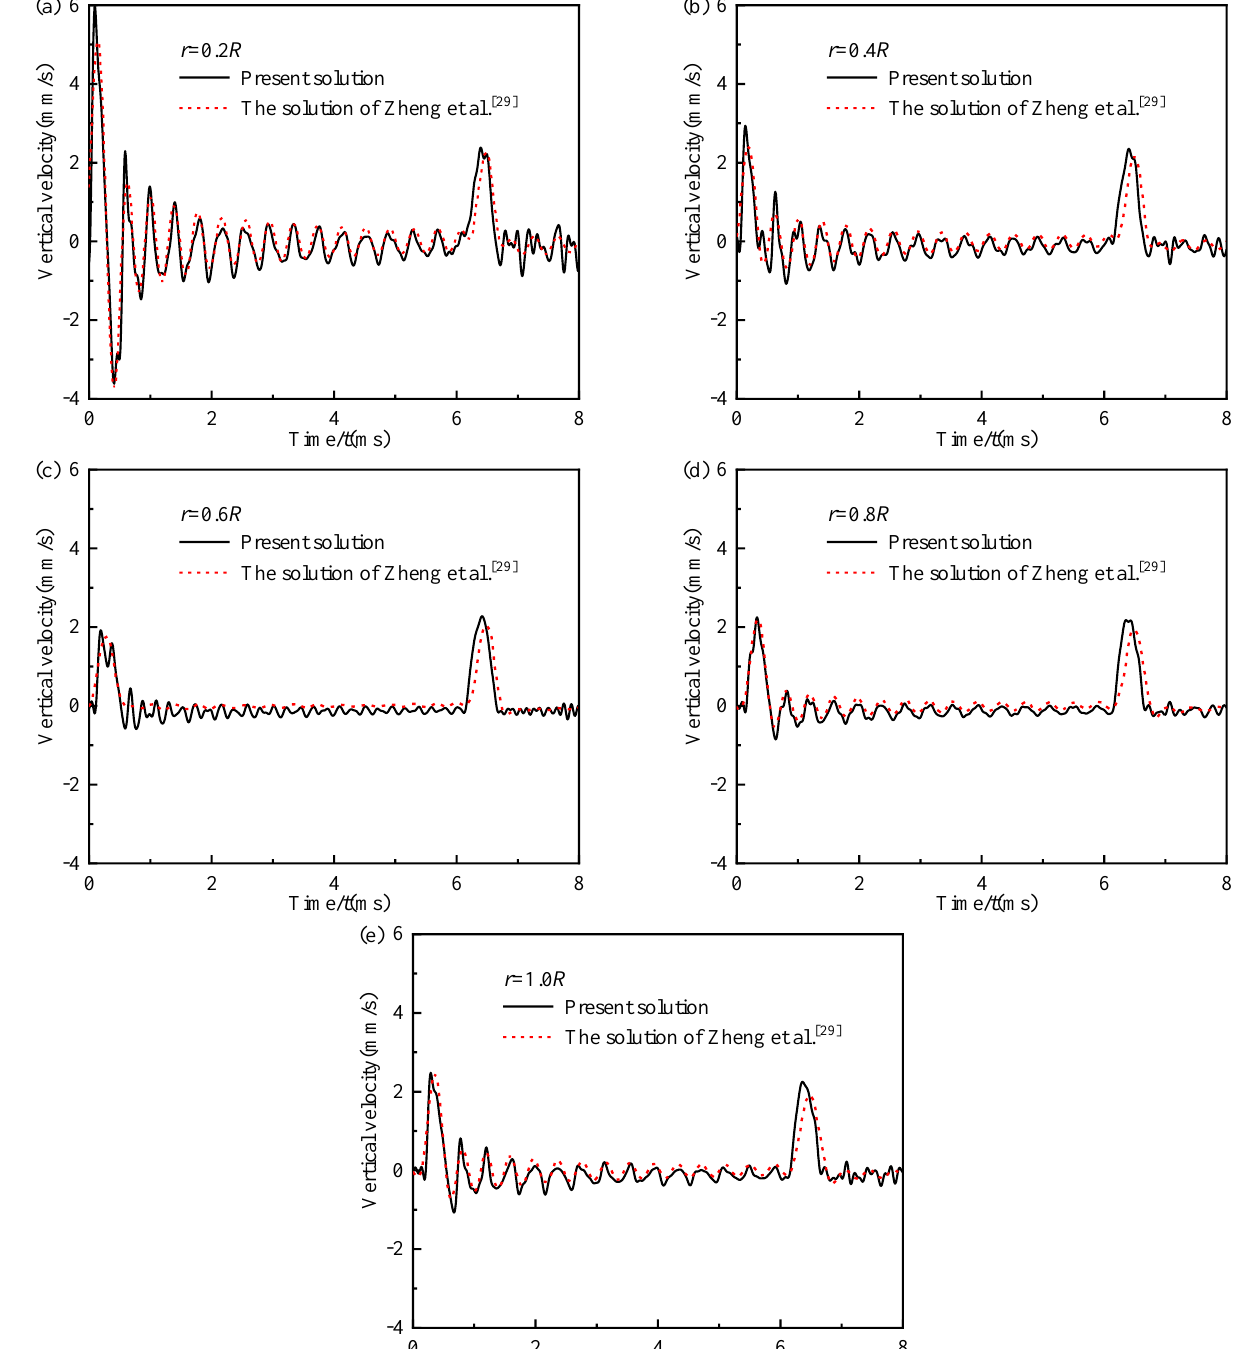
Figure 4. Comparison of the present solution and the solution of Zheng et al. [29] at different testing points along the radius of the large-diameter pile top: ( a ) r = 0.2 R ; ( b ) r = 0.4 R ; ( c ) r = 0.6 R ; ( d ) r = 0.8 R ; ( e ) r = 1.0 R .